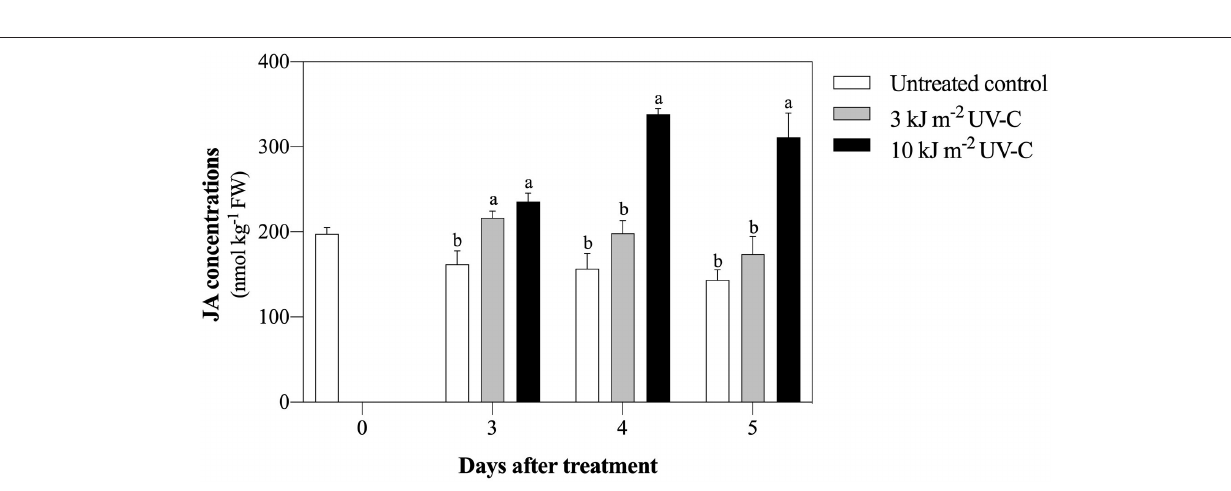
FIGURE 4 | Effect of UV-C treatment on jasmonic acid concentration in satsuma mandarin fruit in untreated control, 3 kJ m − 2 , and 10 kJ m − 2 UV-C groups. The different letters indicate significant differences at P ≤ 0.05 by LSD test at each day with the mean ± SE of three